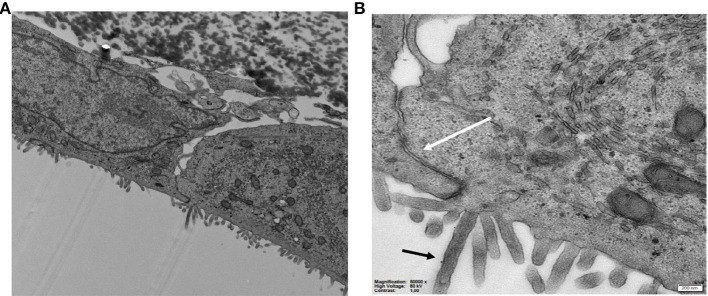
(A,B) TEM images of Caco-2 cells on HFM in the GDFS cultures showing (B) the tight junctions (white arrow) and microvilli (black arrow).